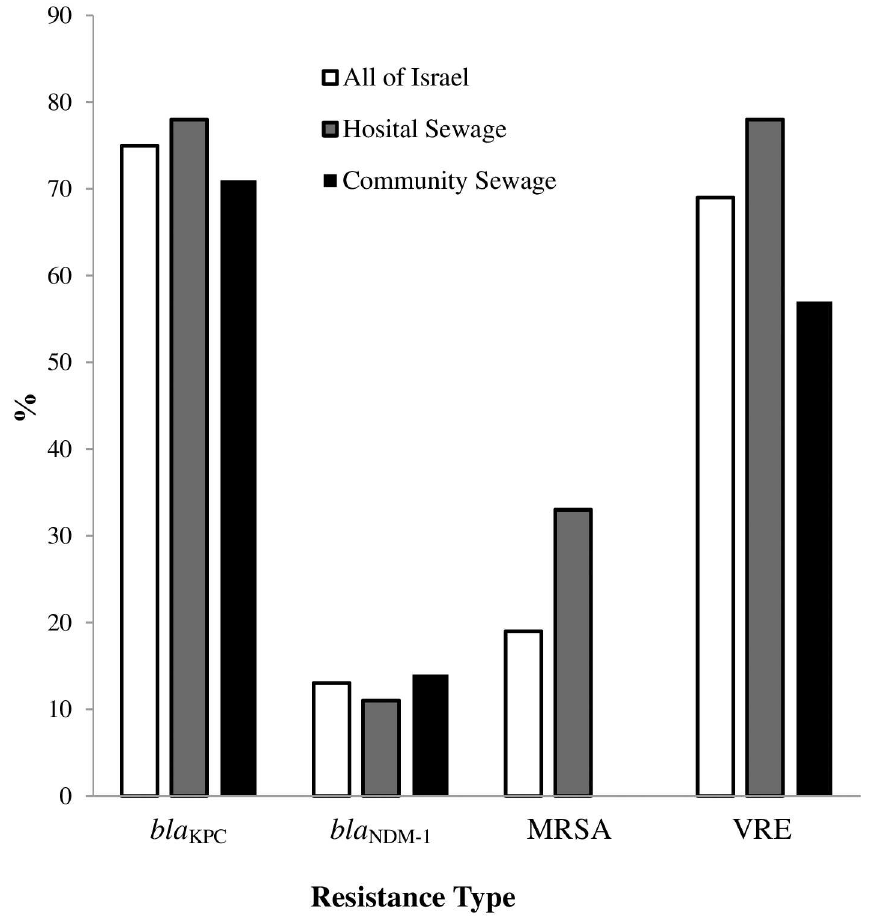
Fig 2. The percentage of pan-resistant bacteria in Israeli sewage containing Hospital compared to Community sewage. No significance was found in the presence of bla KPC , bla NDM-1 , MRSA and VRE between Hospitaland Community sewage ( p = 0.7533, 0.8588, 0.1143 and 0.2989,